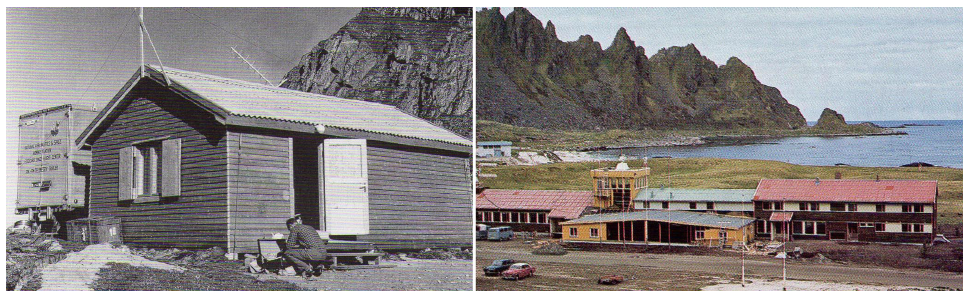
Figure 2. Buildings in 1962 and